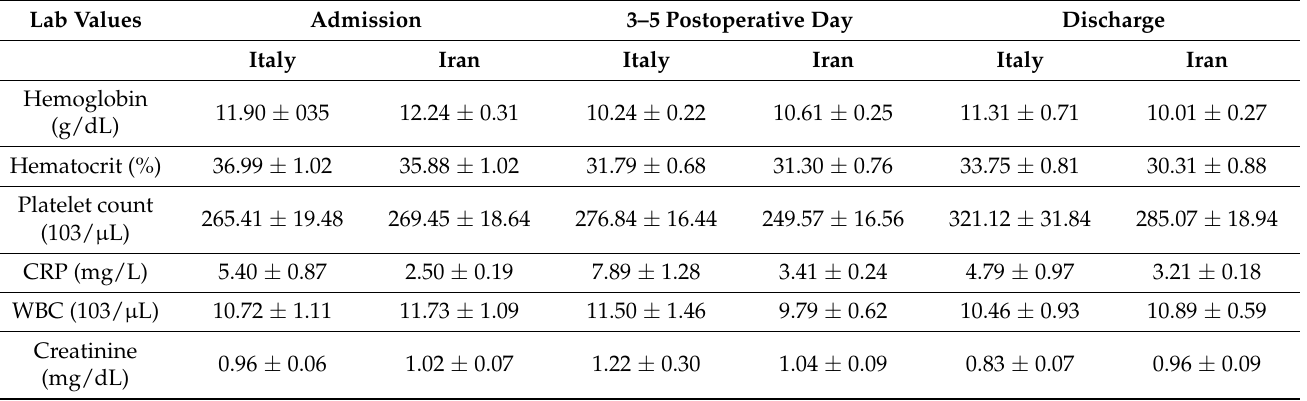
Table 1. Comparison between laboratory values of COVID-19 Italian and Iranian groups upon admission, 3–5 post-operative day and discharge.